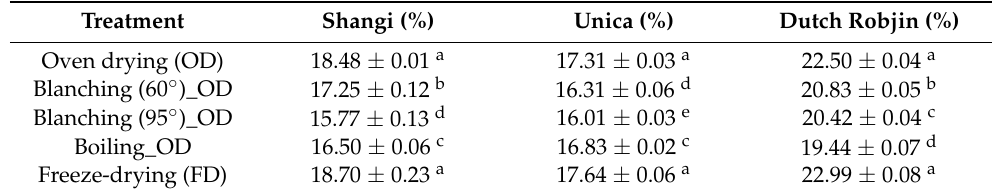
Table 1. Percentage yield of potato flour from three varieties as affected by pretreatments and drying methods.